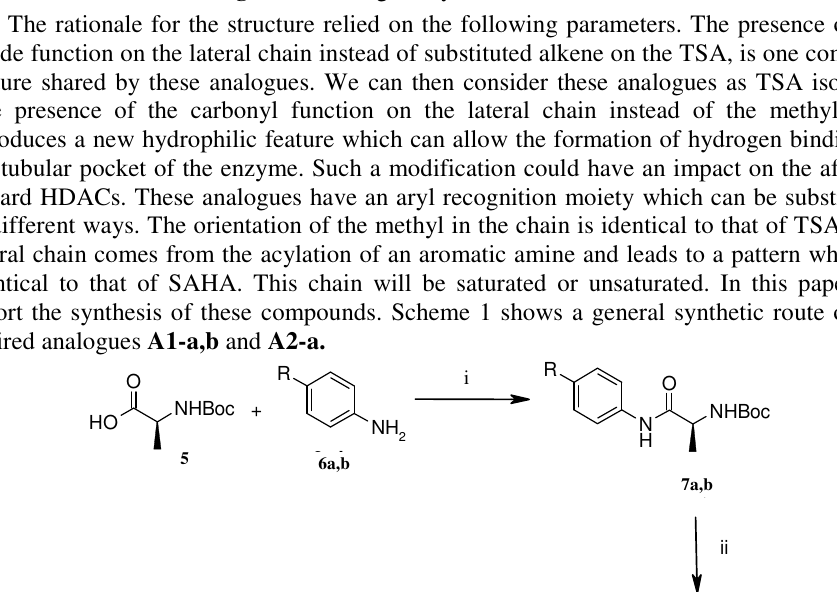
Figure 2. Analogues hybrides